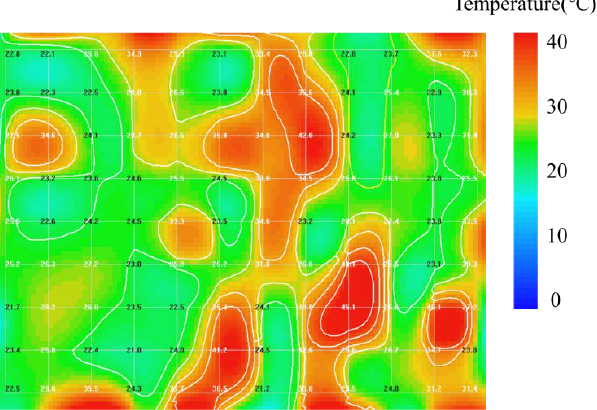
Figure 10. Temperature field cloud map of the second layer on the XOY plane on 4 September 2018. The grain temperature in some areas of the middle exceeds 50 °C, which means that the grain is in the self-heating state. Table 9. The influence of self-heating on the temperature correlation on the XOY plane.